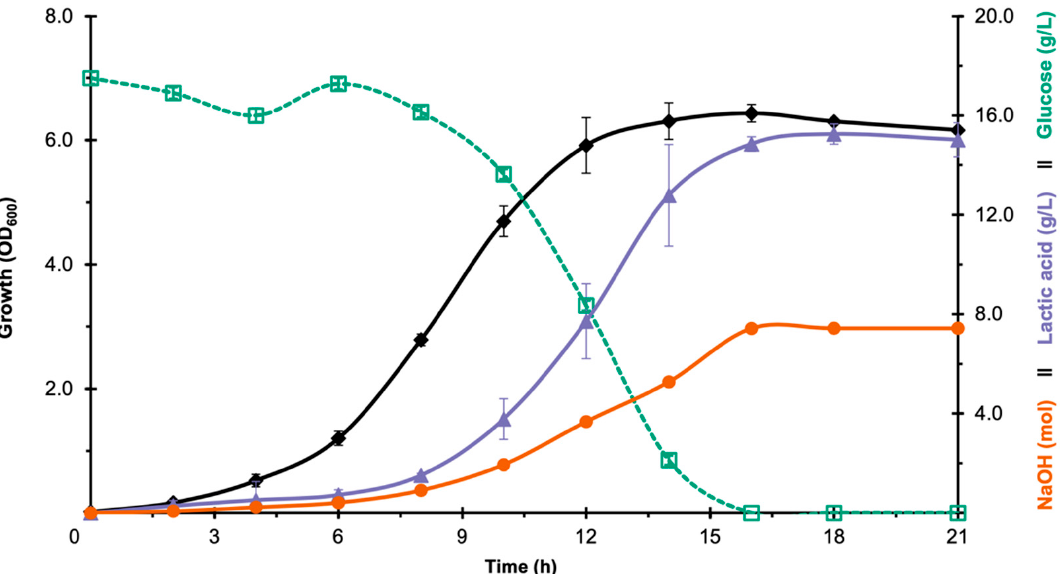
Figure 3. Kinetics of strain Lacticaseibacillus paracasei 6714 in De Man, Rogosa, and Sharpe broth (MRS) media in a 7 L stirred-tank batch bioreactor with an operating volume of 4 L, 0.5 vvm, pH of 6.8, and 37 °C. The values are shown as the mean ± standard deviation, n = 3.